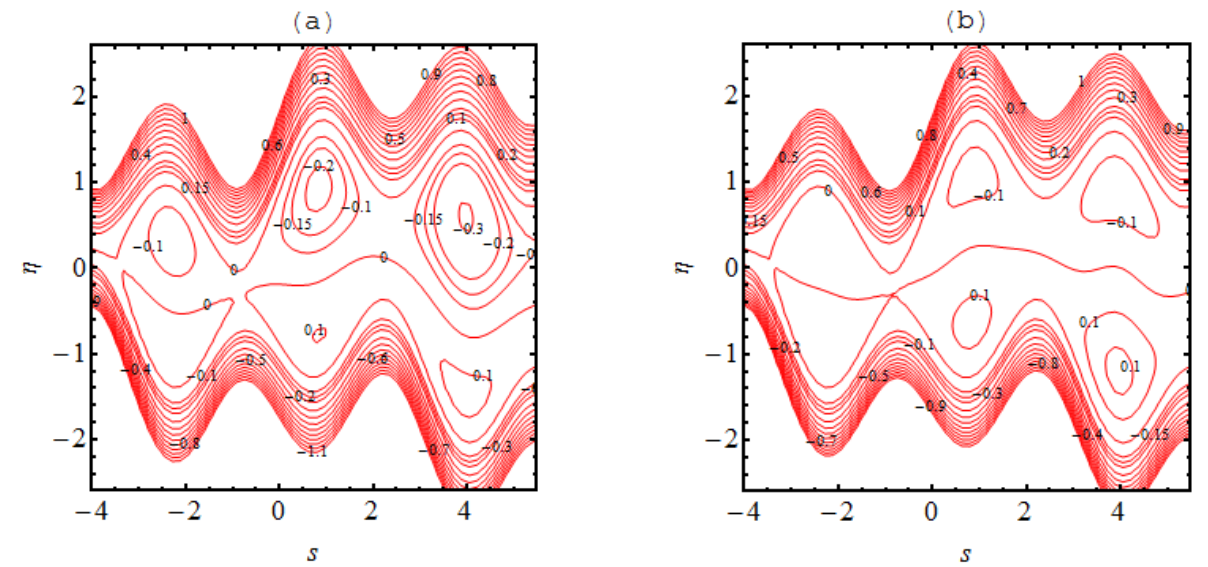
Figure 5. Stream lines for ( a ) Ha = 0.0 and ( b ) Ha = 3.0 the other parameters are α 1 = 0.05, k = 3.0, m = 2.0, q = − 0.1 and α 2 = 0.1.